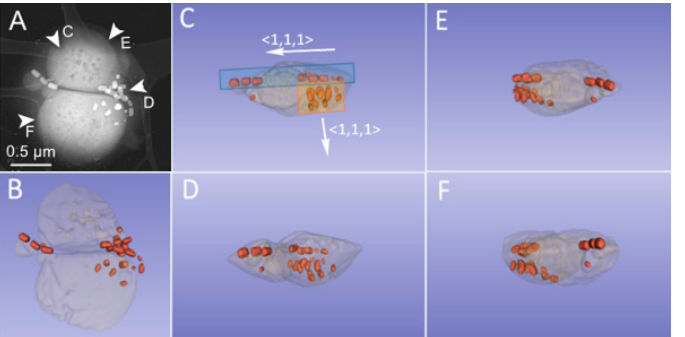
Figure 4. 3D representation of the crystals in the bacteria. ( A ) Dark-field image at 0° tilt angle. ( B – F ) Images corresponding to the viewing directions of the 3D representation indicated by white arrows in ( A ). The white arrows in ( C ) indicate the crystallographic orientation of the crystals.